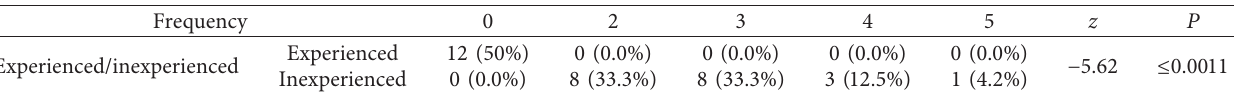
Table 3: Descriptive statistics of frequency and percentage of steering wheel correction frequency among different experience levels without operating car-sharing software.